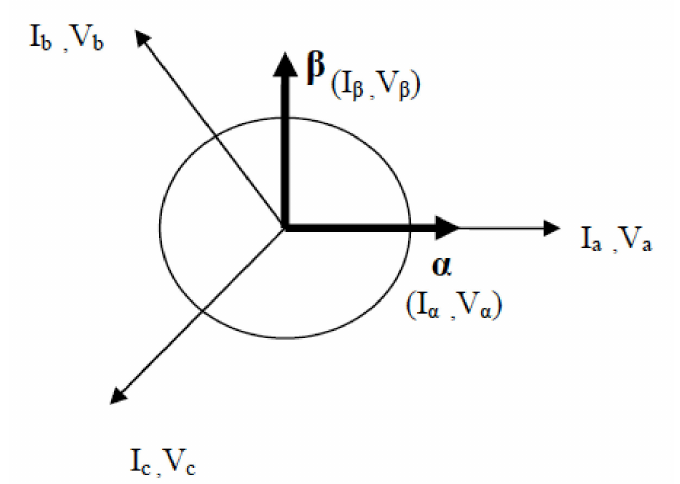
Figure 5. Three-phase a-b-c to α − β